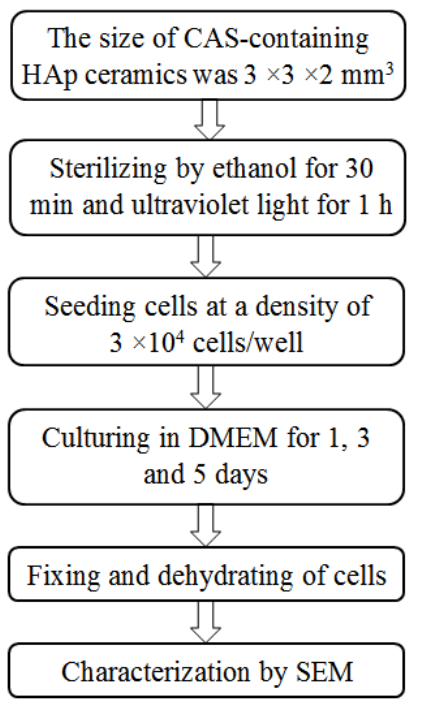
Figure 8. Scheme for cultivation of MG-63